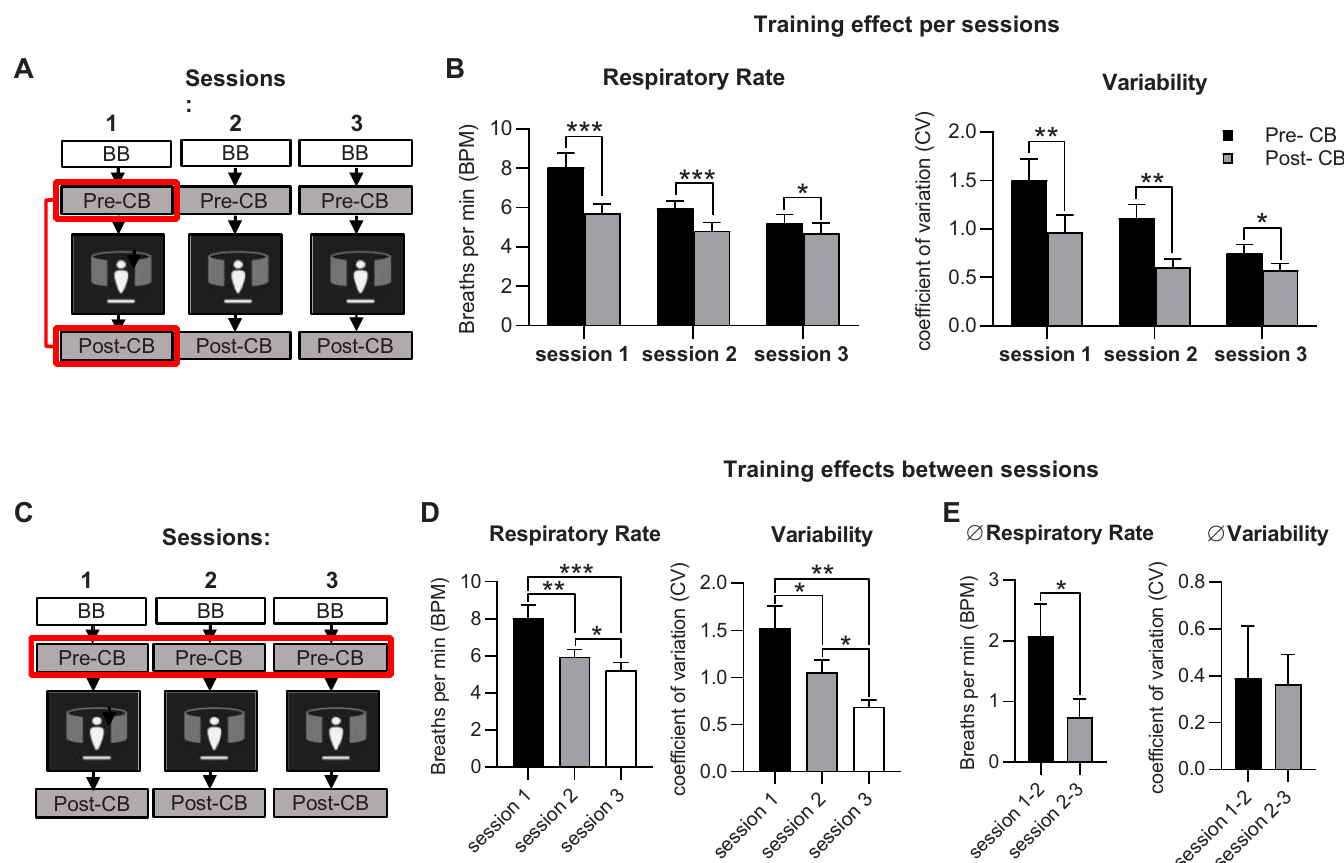
Fig 6. Objective respiratory measures improve with VR-based training. Average respiratory rate (breaths per minute) and respiratory rate variability (standard deviation of rate) collected before (pre-CB) and after training (post-CB) for each session, presented to support comparisons for A/B) each session and C/D) between sessions. E) Differences in pre-training respiratory rate and variability between sessions. (n = 30; data presented as mean ± SEM; � p < 0.05, �� p < 0.01, ��� p < 0.001) BB = Baseline Breathing, CB = Controlled Breathing.